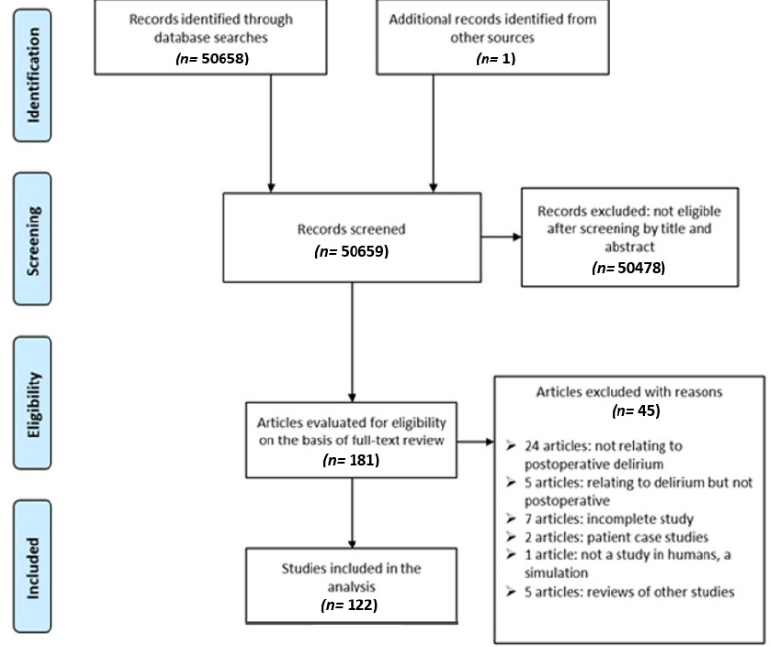
Figure 1. PRISMA flow chart showing the results of the search completed .